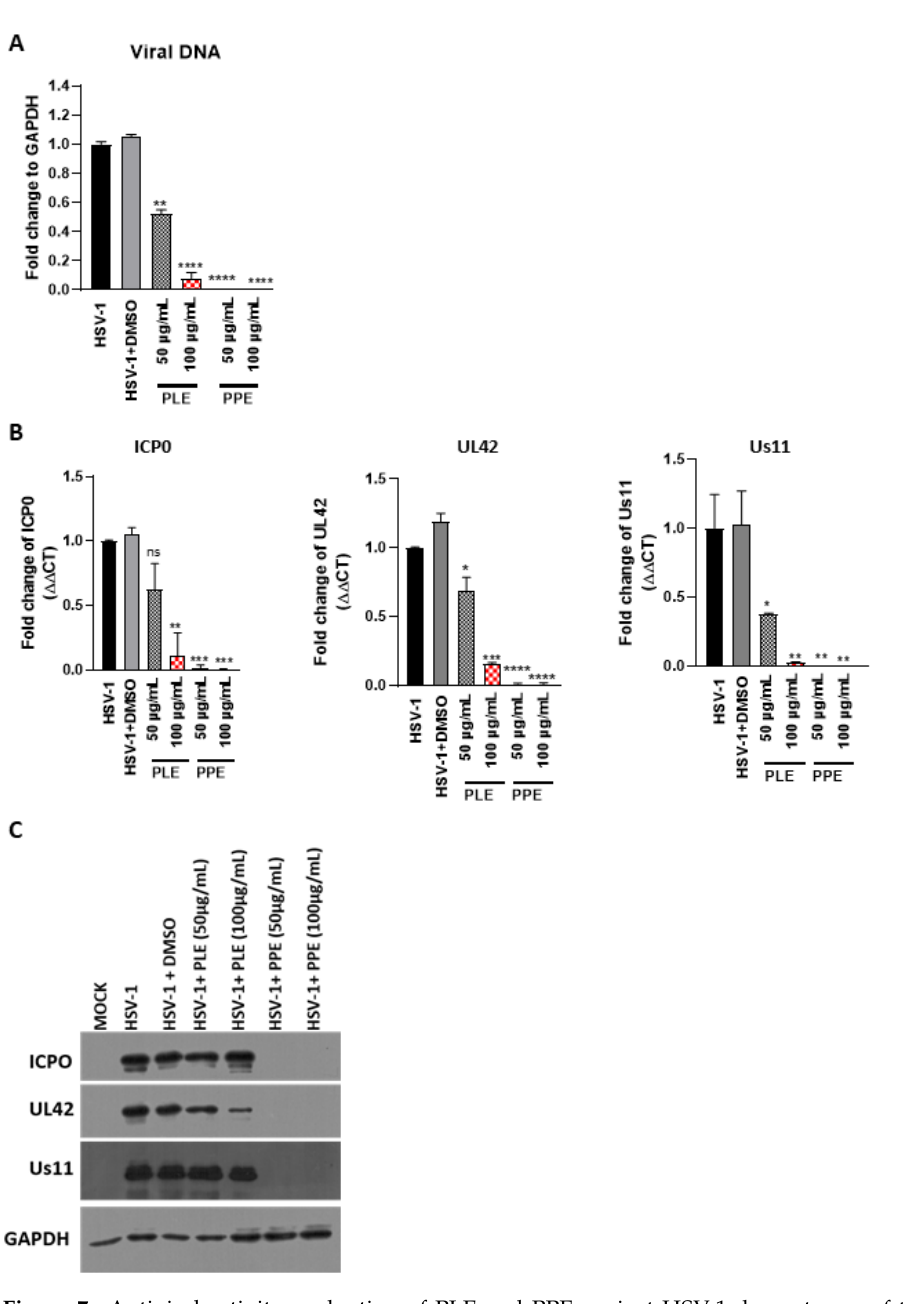
Figure 7. Antiviral activity evaluation of PLE and PPE against HSV-1 downstream of the viral binding. Viral dilution was incubated for 1 h at 4 ◦ C with or without PPE and PLE at 100 µ g/mL and 50 µ g/mL. Then, the infection was performed on Vero cells at a multiplicity of infection (MOI) of 1 with gentle shaking. After 1 h, the virus inoculum was removed, the monolayer was over- laid with a growth medium for 24 h and processed for real-time PCR and Western blot analysis. ( A , B ) Relative quantization of viral DNA and viral transcripts ( ICP0 , UL42 and US11 ) was performed using real-time quantitative PCR and analyzed by the comparative Ct method ( ∆∆ Ct). Values repre- sent ± SD of the average of three independent experiments normalized against GAPDH. ( C ) Western blot analysis of ICP0, UL42 and Us11 viral proteins. GAPDH was used as a housekeeping gene. The quantitative densitometric analysis for ICP0, UL42 and Us11 band intensities was determined using ImageJ software and expressed as fold change over the appropriate housekeeping gene. * p < 0.05, ** p < 0.01, *** p < 0.001, **** p < 0.0001 vs. HSV-1 +